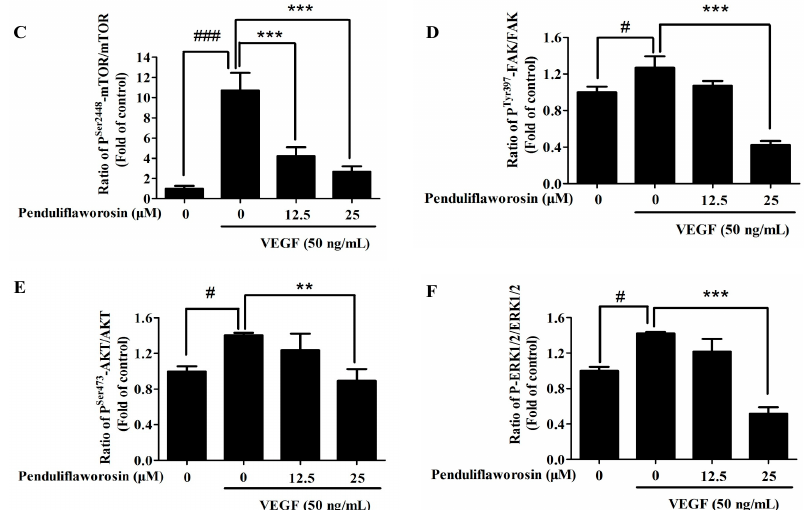
Figure 6. ( A ) Effect of penduliflaworosin on the expression of the phosphorylation of VEGF receptor-2 (VEGFR-2) and VEGFR-2 downstream signaling molecules, including mammalian target of rapamycin (mTOR), focal adhesion kinase (FAK), protein kinase B (AKT), and extracellular signal-regulated kinase (ERK) in HUVECs in a dose-dependent manner. ( B – F ) The ratios of phospho Tyr1175 -VEGFR-2/VEGFR-2, phospho Ser2448 -mTOR/mTOR, phospho Tyr397 -FAK/FAK, phospho Ser473 -AKT/AKT, and phospho-ERK1/2/ERK1/2 were determined, respectively. Values are represented as the mean ± standard deviation ( n = 3). Mean values showing significant differences between the control group and the VEGF-treated group are denoted by # ( p < 0.05), ## ( p < 0.01), or ### ( p < 0.001). Mean values showing significant difference between the VEGF-treated group and penduliflaworosin-treated group are indicated by ** ( p < 0.01) or *** ( p < 0.001).